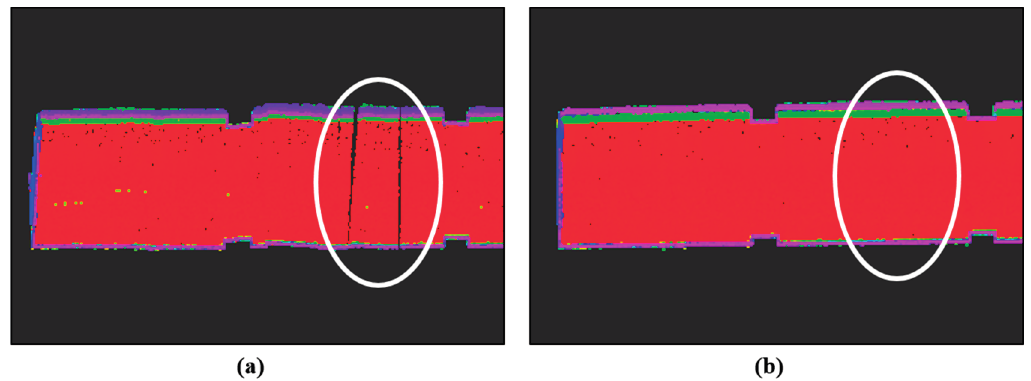
Figure 16. Detailed view of the corridor ( a ) without and ( b ) with the constraint